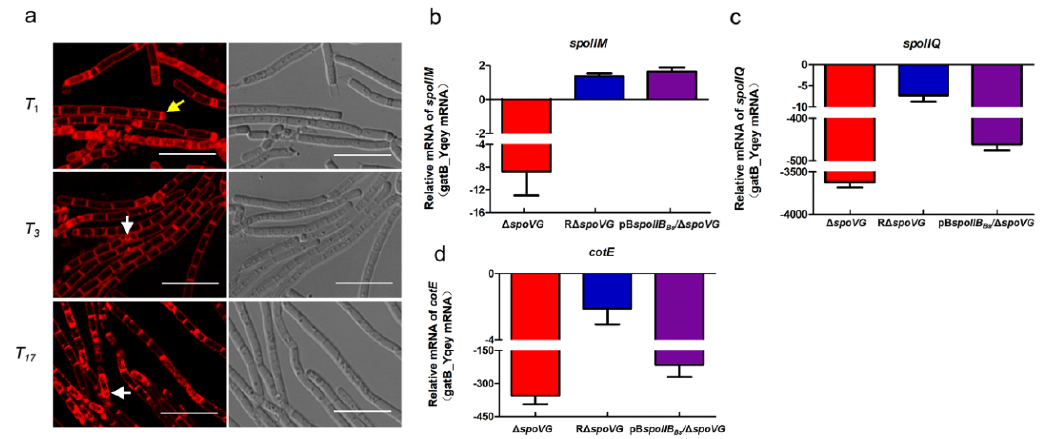
Figure 6. Morphological and molecular characteristics of the B. anthracis pB spoIIB Bs / ∆ spoVG strain during sporulation. ( a ) Confocal laser-scanning micrographs (scale bar, 10 µ m) of strain pB spoIIB Bs / ∆ spoVG at T 1 , T 3 , and T 17 . The cell membrane is visible as red fluorescence. Yellow and white arrows indicate the asymmetric septum and engulfed cells (prespores), respectively. ( b–d ) Relative mRNA expression of genes spoIIM , spoIIQ , and cotE determined in the ∆ spoVG , R ∆ spoVG , and pB spoIIB Bs / ∆ spoVG strains compared with strain A16R (wild-type) at T 17 using RT-qPCR. Values represent means ± SDs of at least two experiments.